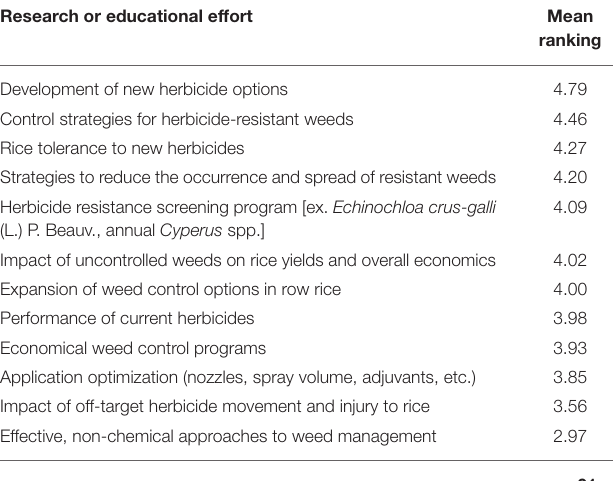
TABLE 2 | Importance of current research or educational efforts as rated by survey respondents on a scale of 1–5, where 1 = not important, 2 = slightly important, 3 = moderately important, 4 = very important, and 5 = extremely important.